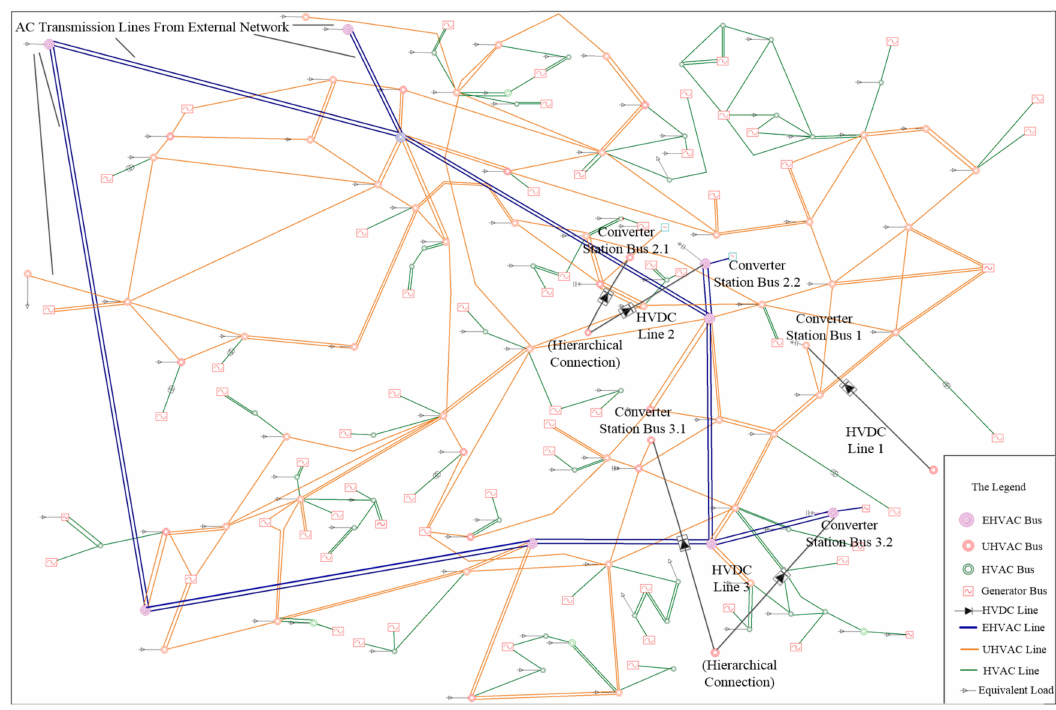
Figure 7. Network structure of the reduced system.